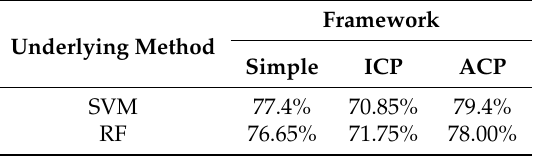
Table 3. Classification accuracy of different